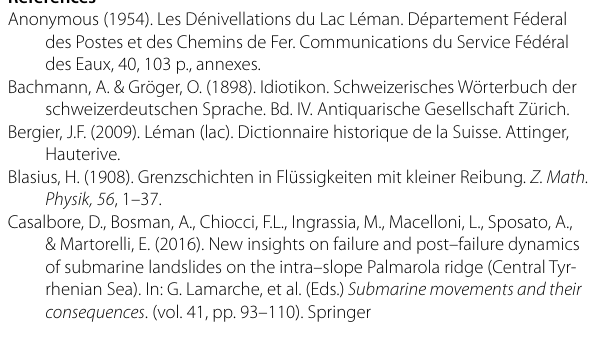
The forecast seiche amplitude of the 1601 CE event, 1.88 m, is in the estimated range of 1–2 m (Schnellmann, 2004; Siegenthaler et al., 1987). The same procedure leads to an amplitude of 2.42 m, respectively 10 m at Geneva for the 563 CE event. f figures the increase of the seiche amplitude at Geneva shown on February 12, 1950, and on July 28, 1950, due to the funnel-shaped “Petit Lac”; it must be noted, that the values in the last column are independent on f . The much larger energy ratio in Lake Geneva as compared with Lake Lucerne is expected due to the complicated basin geometry of the latter. The 563 CE seiche–amplitude at Lausanne is estimated to be around 1 m for an expected one–node seiche and is much less compared than the 13 m tsunami simulation (Kremer et al., 2012). Such a large event would have been probably mentioned by the bishop of the diocese Lausanne